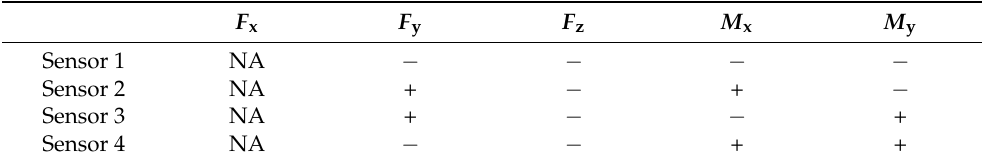
Table 2. Positive and negative directions of the sensor outputs when each directional force and moment are applied. F x F